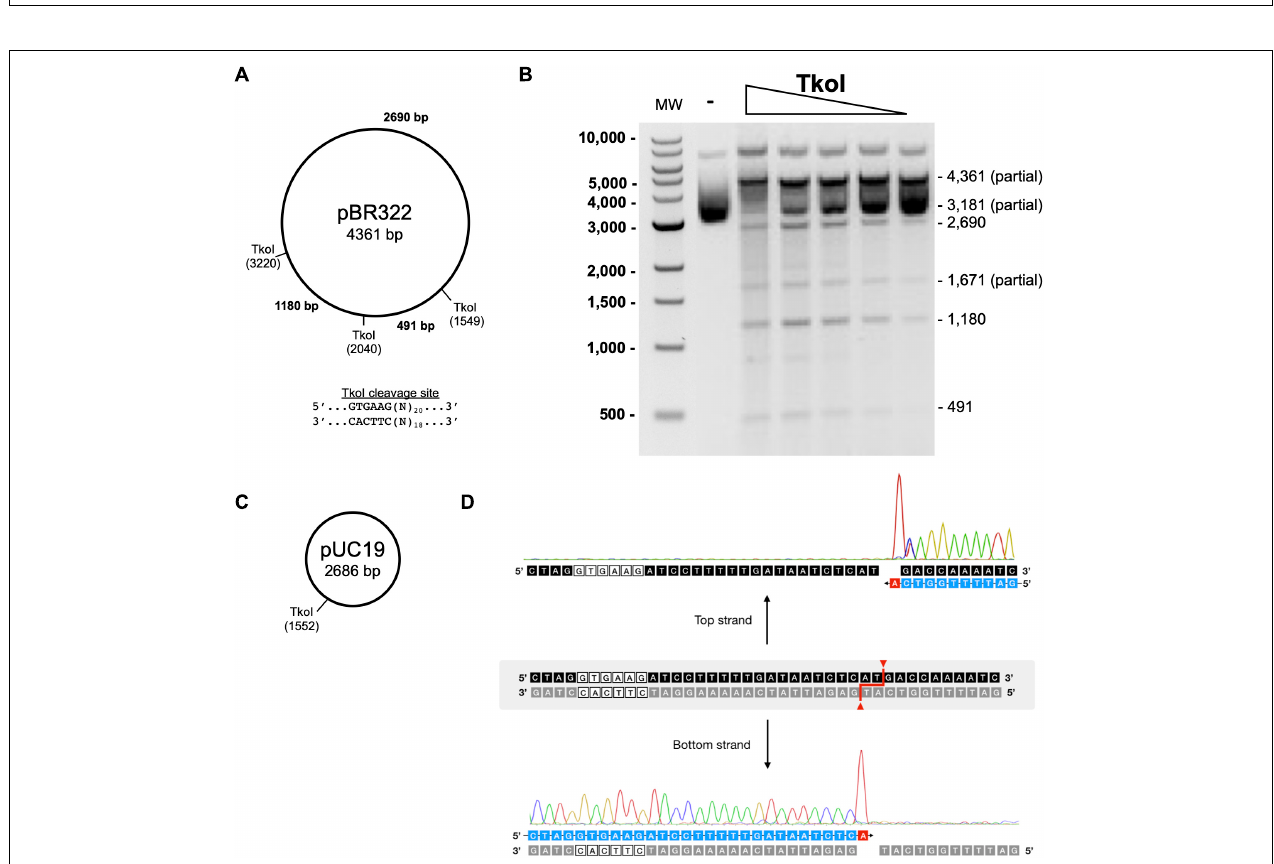
FIGURE 4 | In vitro characterization of MTase activities of TkoI and TkoII. Site-specific MTase activities of (A) TkoI (blue) and (B) TkoII (red) were confirmed by the transfer of 3 H-methyl groups to DNA substrates (TkoI or TkoII oligo) from 3 H-methyl SAM ( 3 H-SAM). Reactions lacking enzymes or 3 H-methyl SAM displayed background levels of 3 H-methyl transfer, as did reactions of TkoI or TkoII with substrate lacking the defined recognition sites. Reactions were completed in triplicate.